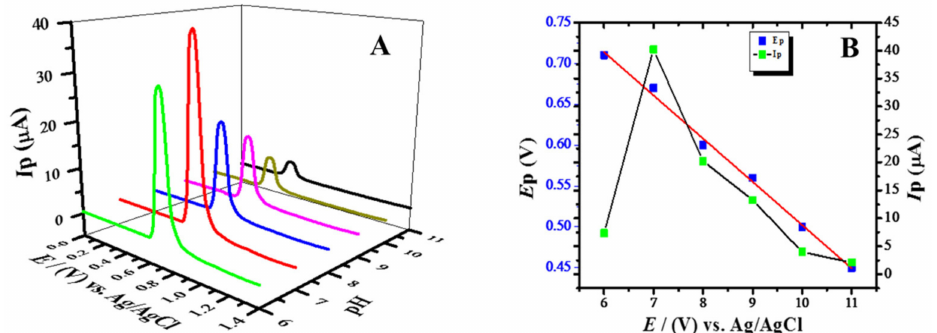
Figure 8. ( A ) Square wave voltammograms of the 2 µ M solution of VEN in media of different pH obtained at a scan rate of 50 mV/s, accumulation potential of − 0.5 V, and accumulation time of 60 s. ( B ) Plots of the peak potentials and peak currents versus